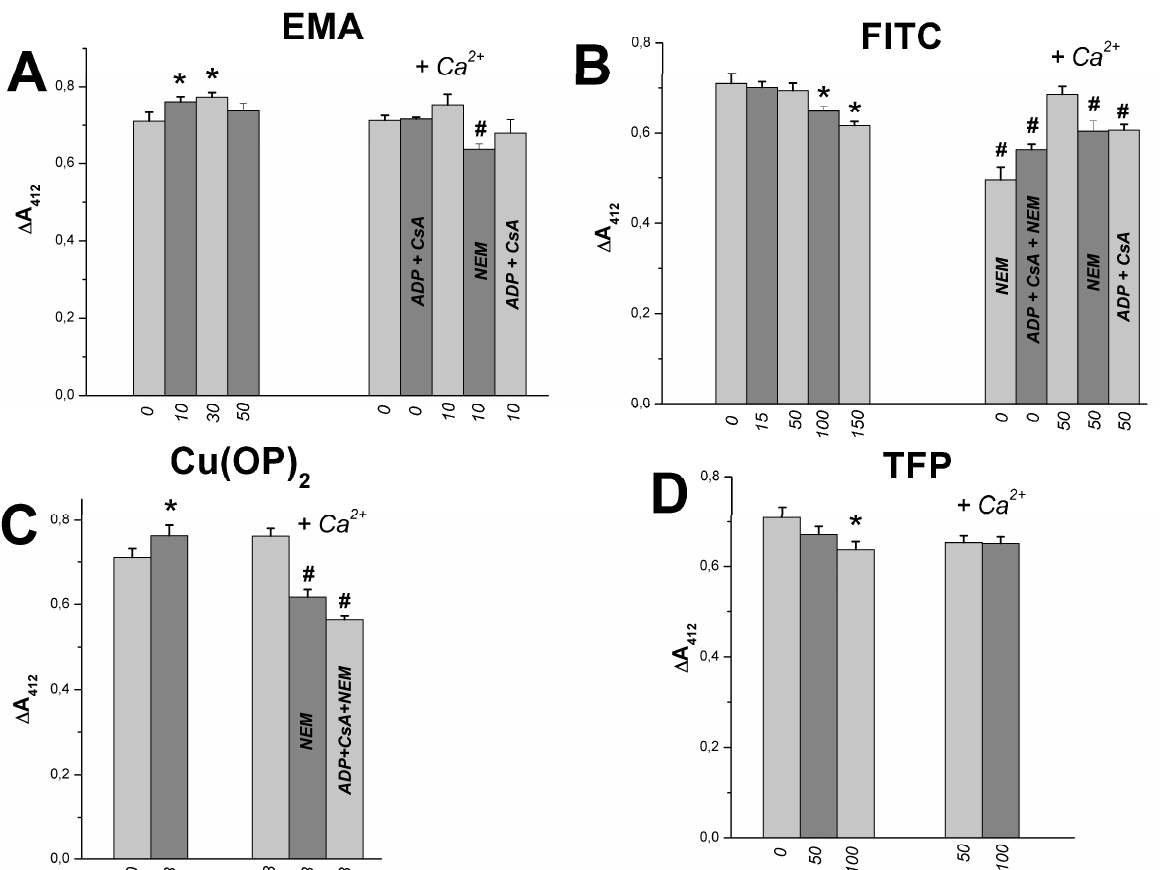
Figure 12. Effects of EMA, FITC, Cu(OP) 2 , TFP, and Ca 2+ on the SH-group content in succinate-energized rat liver mitochondria in thallium nitrate medium. Mitochondria (1 mg protein/mL) were added into Eppendorf tube with 1 mL of the medium A (pH 7.3) containing 75 mM TlNO 3 , 125 mM KNO 3 , 5 mM succinate and 100 μ M Ca 2+ (Ca 2+ , where indicated). Reagents (EMA ( A ), FITC ( B ), Cu(OP) 2 ( C ), TFP ( D )) were injected into the medium before mitochondria. Then, mitochondria, after 5 min incubation at 20 °C, were sedimented at 10,000 rpm in the Beckman Centrifuge (see Methods). Numbers near the abscissa axis show the concentration ( μ M) of the reagents. Double measurements in the absorbance changes ( Δ A 412 ) were calculated for three different mitochondrial preparations, and these are shown as Means ± SEM. Asterisks and hash signs indicate correspondingly statistical differences between appropriate values and the control (free of thiol reagents or Ca 2+ alone) which are statistically significant ( p < 0.05).